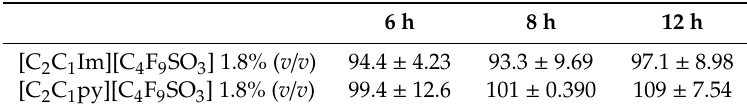
Mean values calculated from two independent assays and their standard deviations.